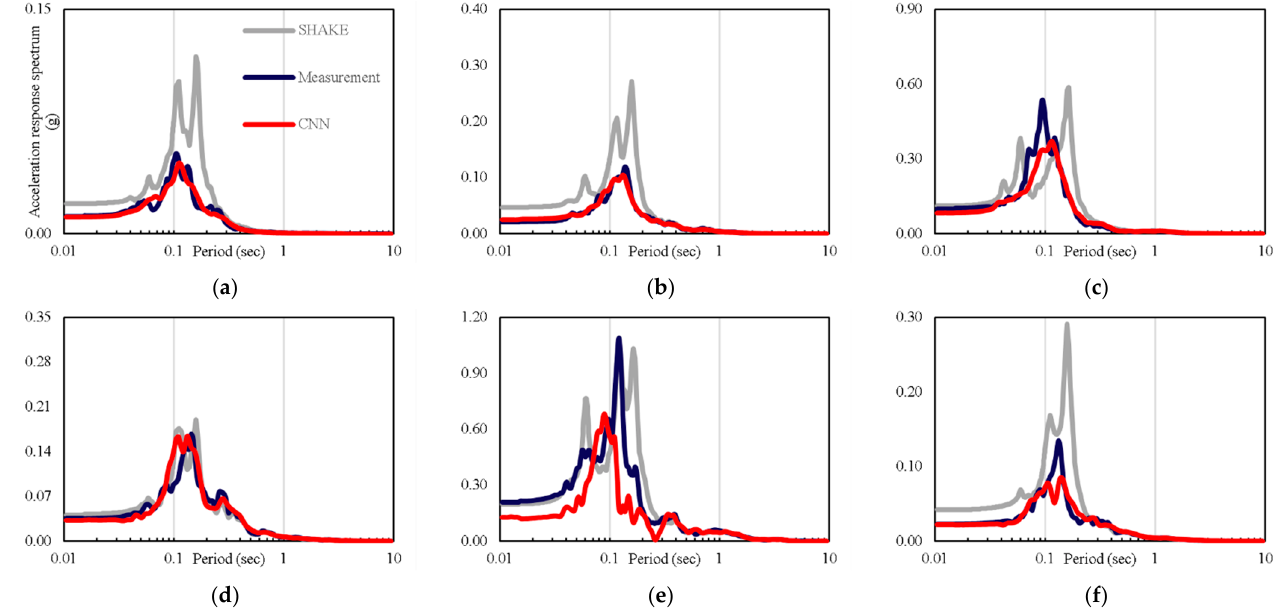
Figure 20. The six samples of acceleration response spectra measurements and predictions at site IWTH27. ( a )